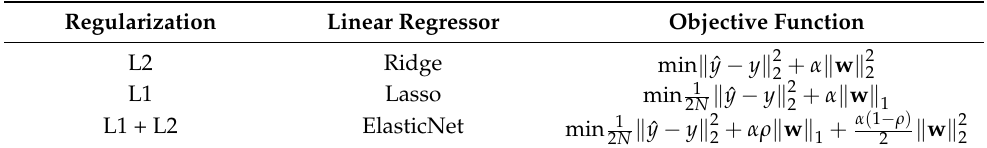
Table 2. Regularized objective